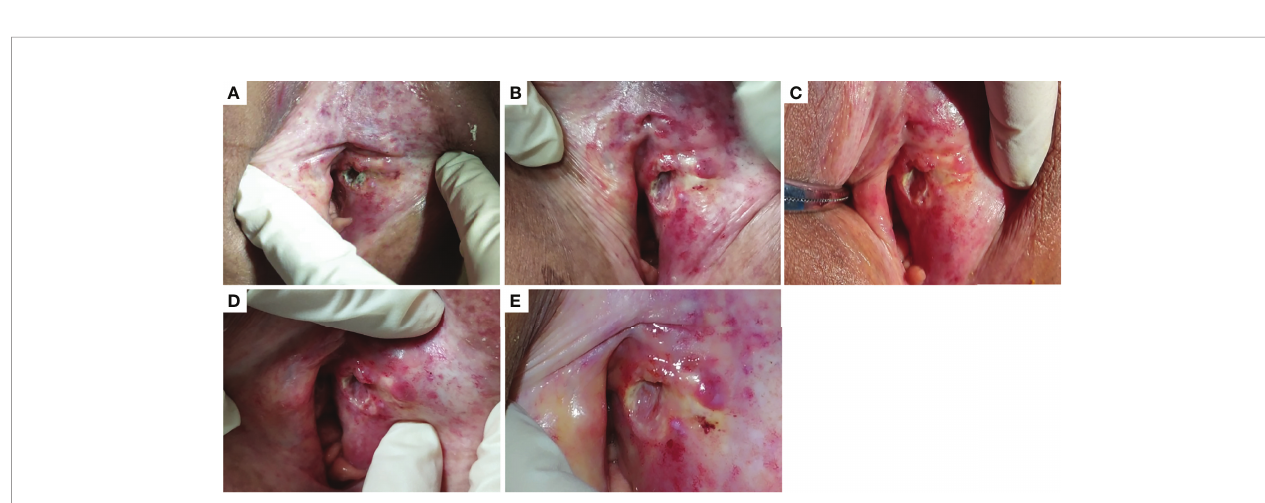
FIGURE 6 | One patient with recurrent vulvar cancer had a lesion at left labia majora presented as an ulcer with foul pus on the surface (A) . With 5 days of continuous injection, the local state of the lesion gradually improved, and the ulcerated surface of the lesion was shallower and cleaner. (B – D) showed the changes of lesions after the fi rst, third and fi fth injection in the injection cycle, respectively. (E) showed the lesion in outpatient review after 1 week of this cycle of